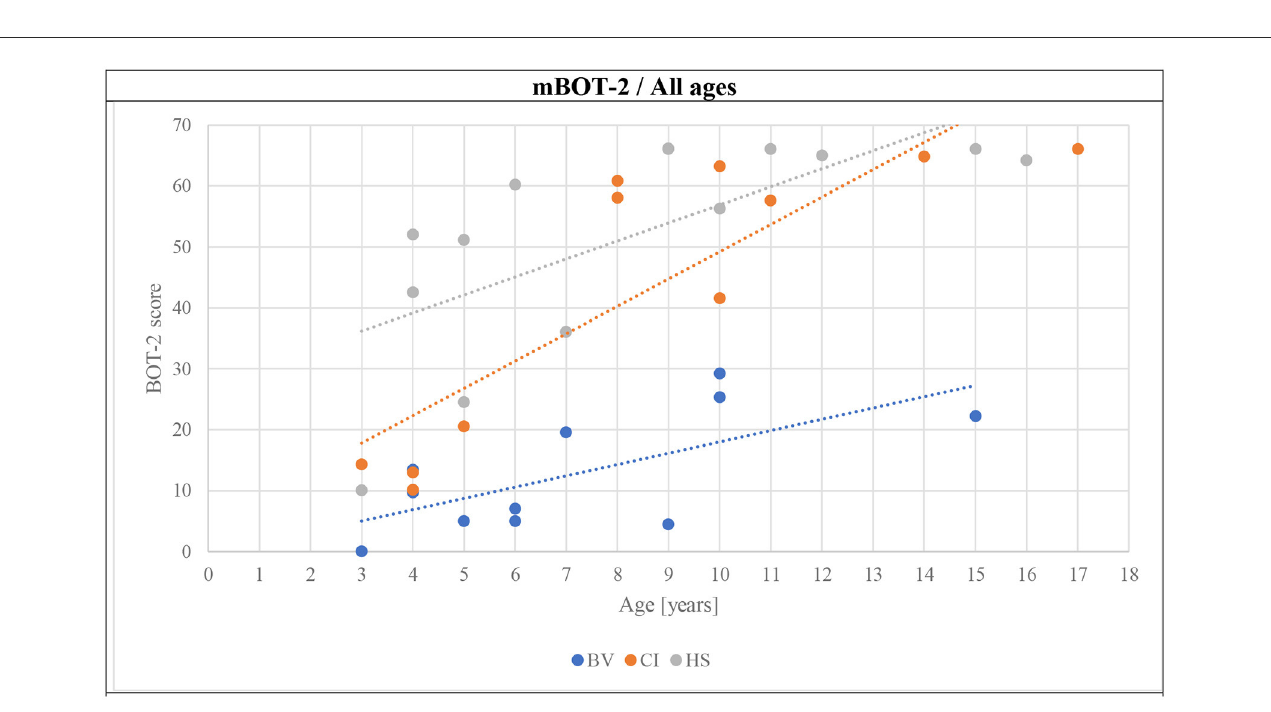
FIGURE8 Evolution of the mBOT-2 scores of all subjects as a function of age (BV, blue symbols; CI, orange symbols; HS, gray symbols).